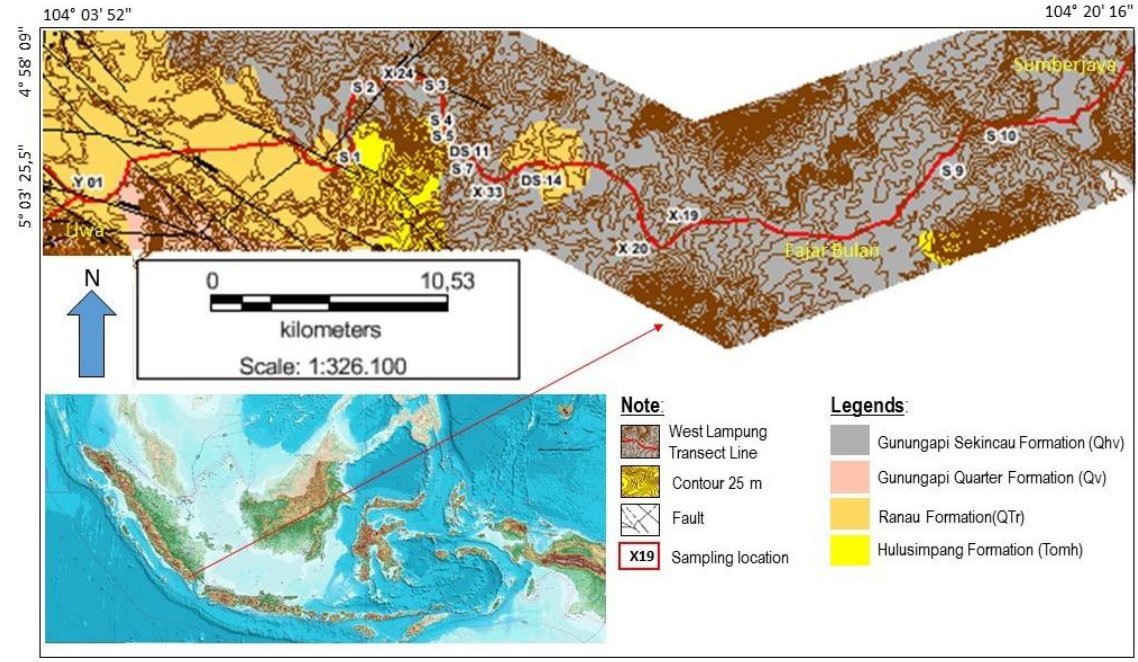
Fig. 1. Research area, sampling location, and simplified regional geological map (modified from www.big.go.id)